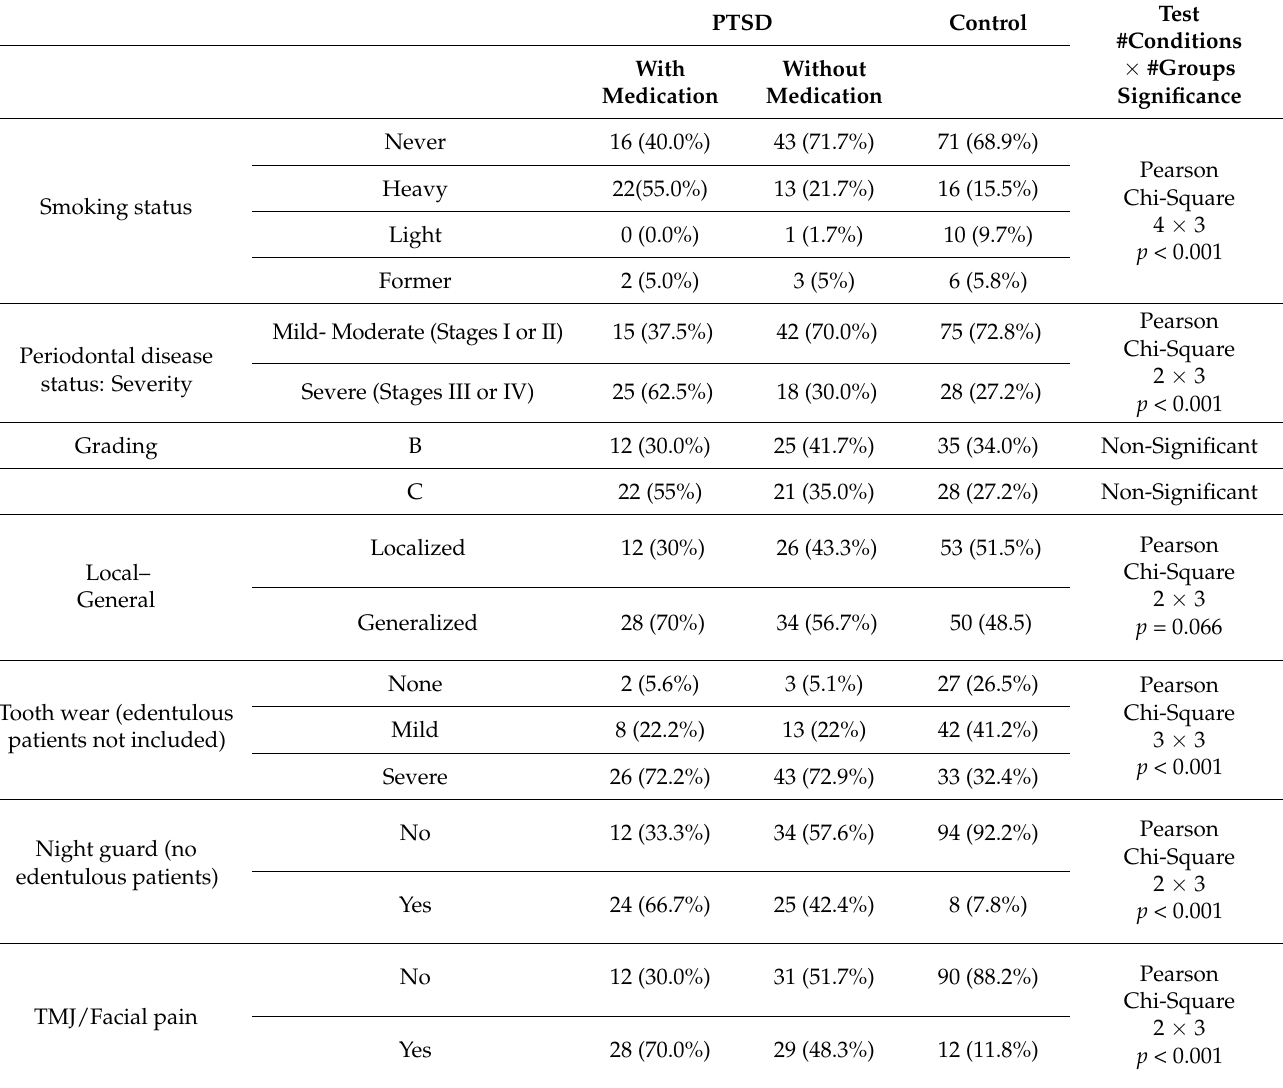
Table 2. Examined Variables—Counts and Tests Significance of Differences and